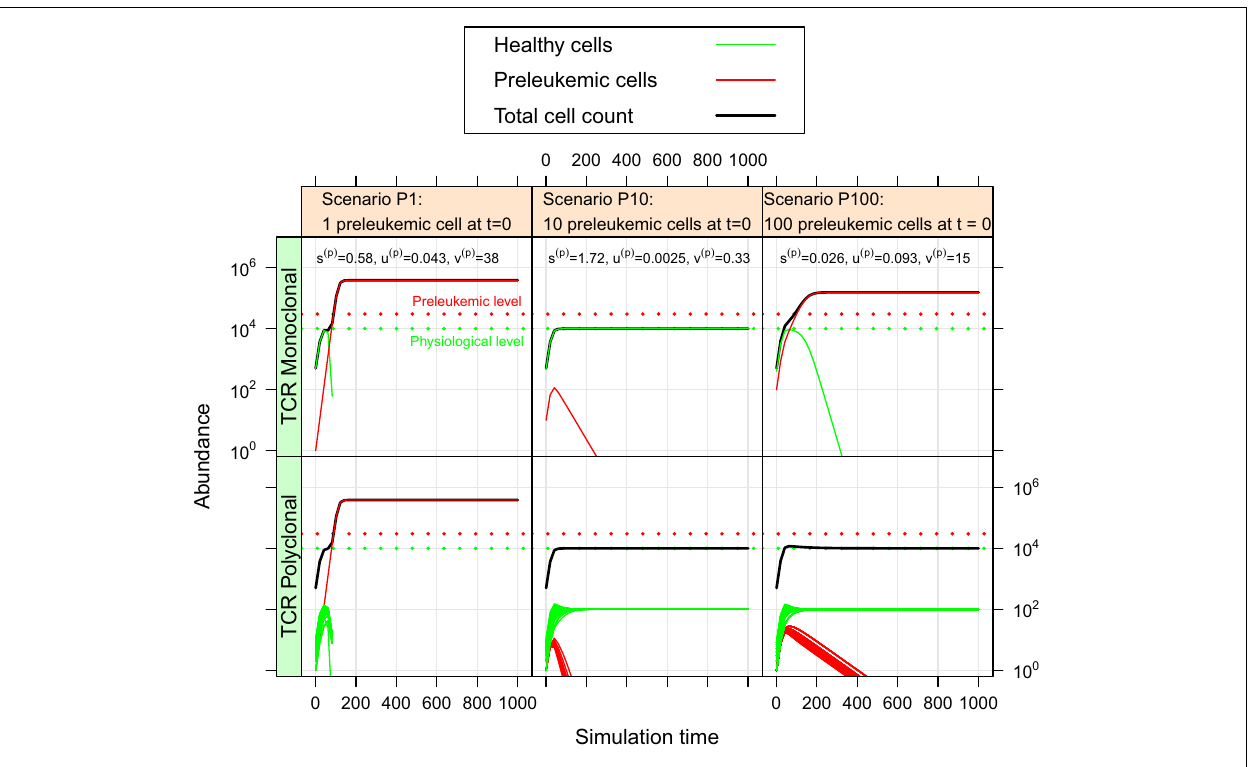
The parameter set chosen for P10 is also not consistent with the specified criteria. Using this parameter set, the preleukemic cells are less fit than the healthy cells, and die out both in the mono- and the polyclonal situation.The parameter set chosen for scenario P100 is consistent with the specified criteria.